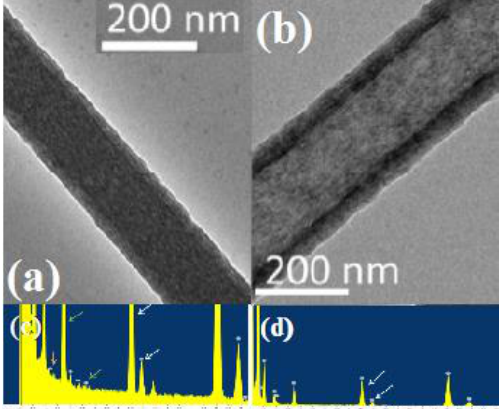
Figure 2. TEM micrographs of the TiO